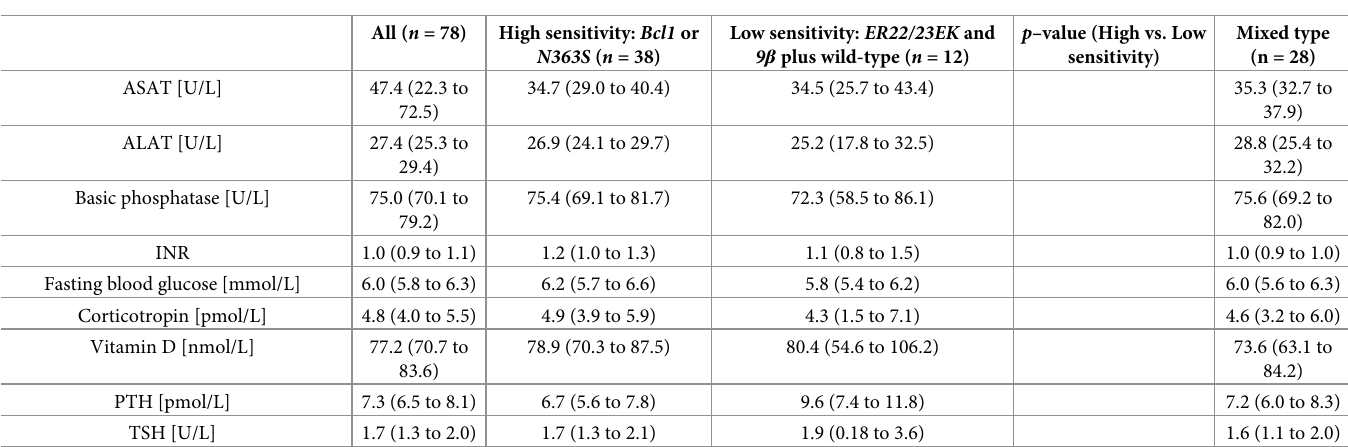
Table 2. Relationship between 30 min cortisol response and possible confounders in the total cohort (N = 78).